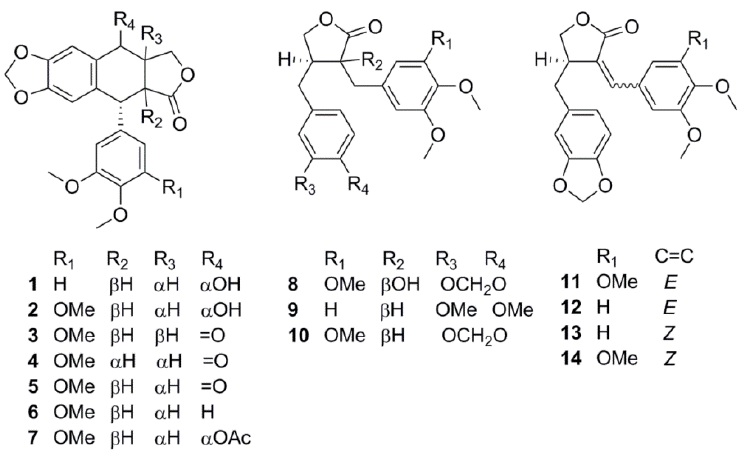
Figure 1. Structures of the investigated compounds.